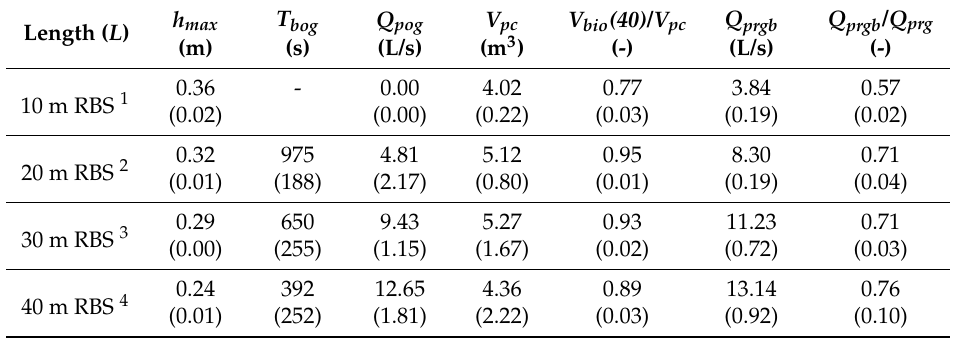
Table 7. Mean and standard deviation (numbers inside brackets) of additional simulation results calculated from each of the five road-bioretention cases with the same L (10–40 m). h max T bog Q pog V pc V bio (40)/V pc Q prgb Q prgb /Q Length ( L )